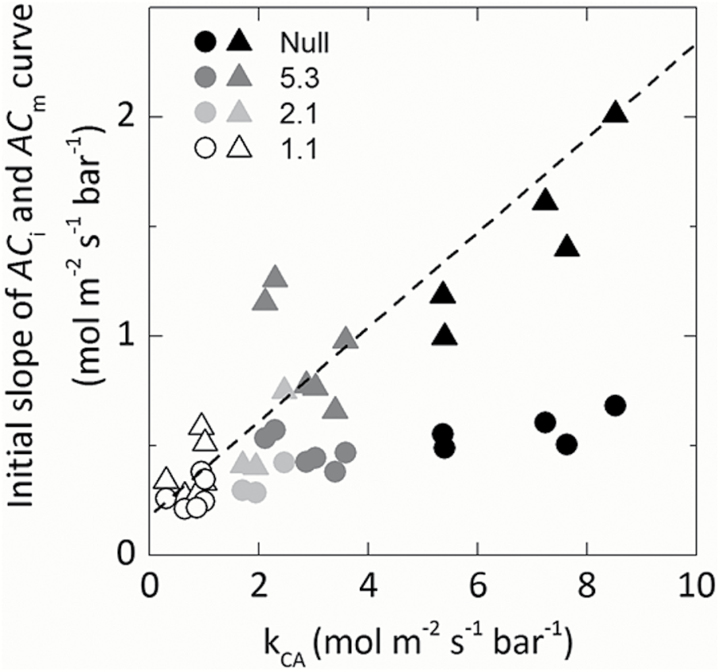
Relationship between the initial slope of the ACm (triangles) or ACi (circles) curves and the rate constant of CA hydration rates (kCA), ACmR2=0.846. Each point represents a measurement made on an individual leaf of a T2 plant.